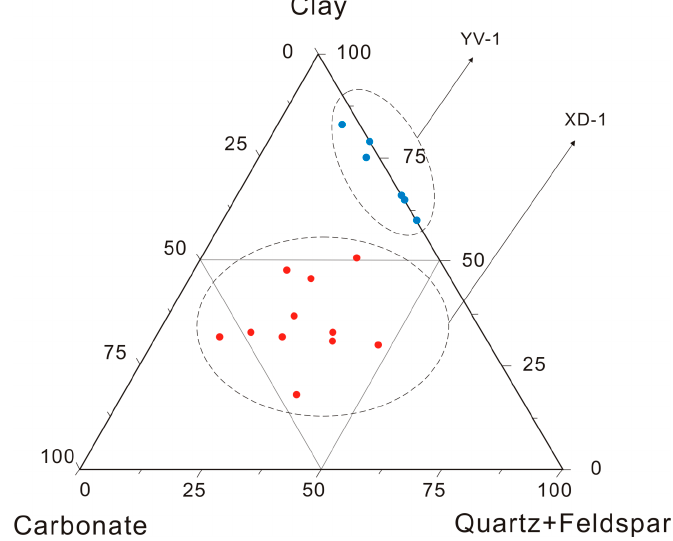
Figure 4. Mineralogical ternary diagram of transitional Longtan Shale samples from YV-1 and XD-1.